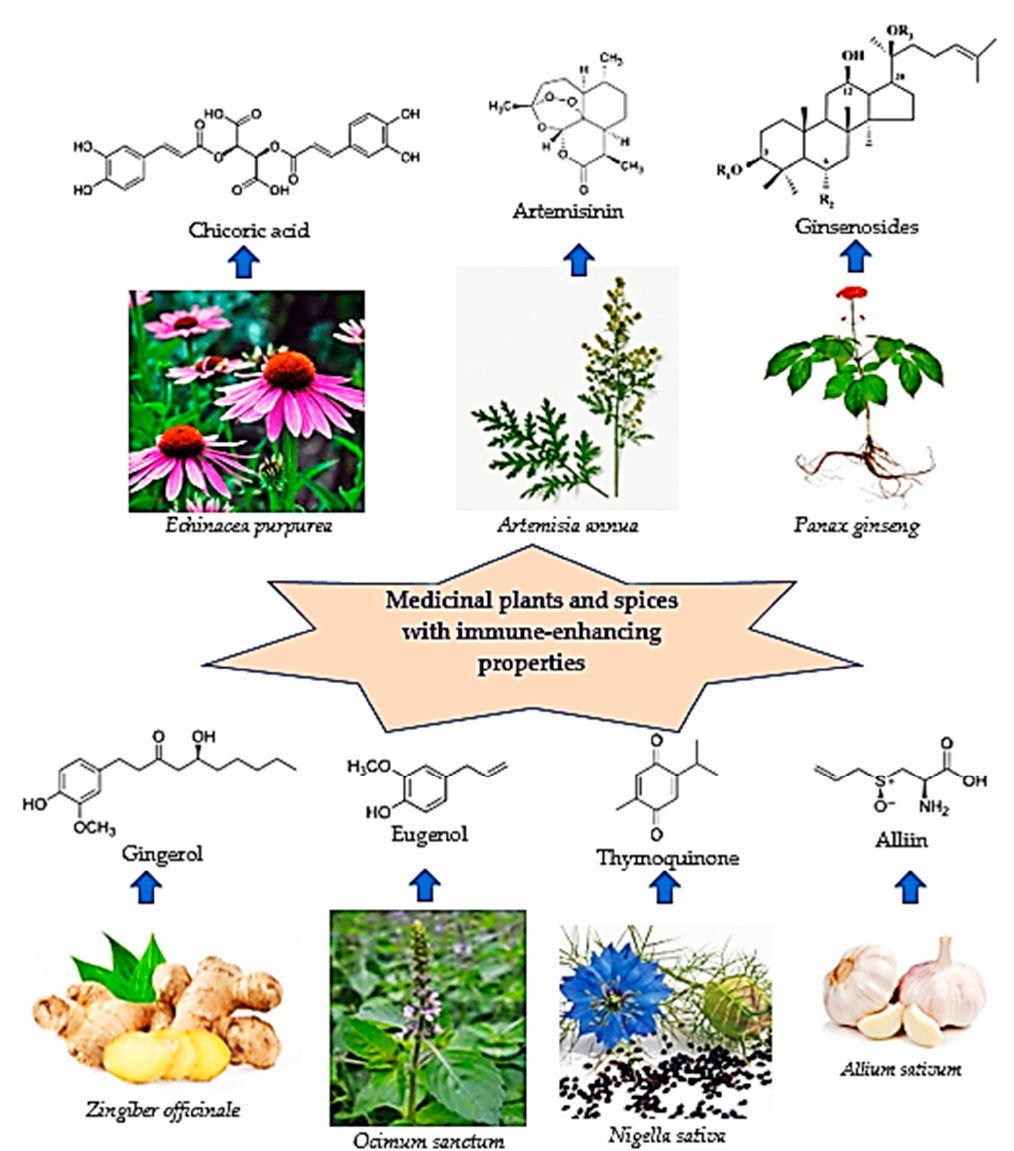
Figure 1. The most important medicinal plants and spices with immunomodulatory activity.